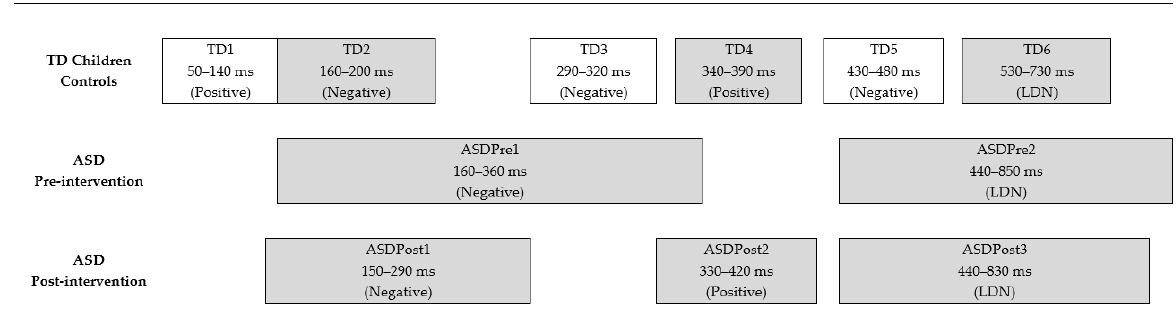
Figure 3. Difference waveforms (deviants-minus-standard), combined across emotions and electrode sites, resulting in a single grand average difference waveform for each group—TD children (thick solid [black] line), and ASD children pre- (thin solid [purple] line) and post-intervention (thin dotted [purple] line). Response amplitudes are measured in microvolts ( μ V) and time in milliseconds (ms).